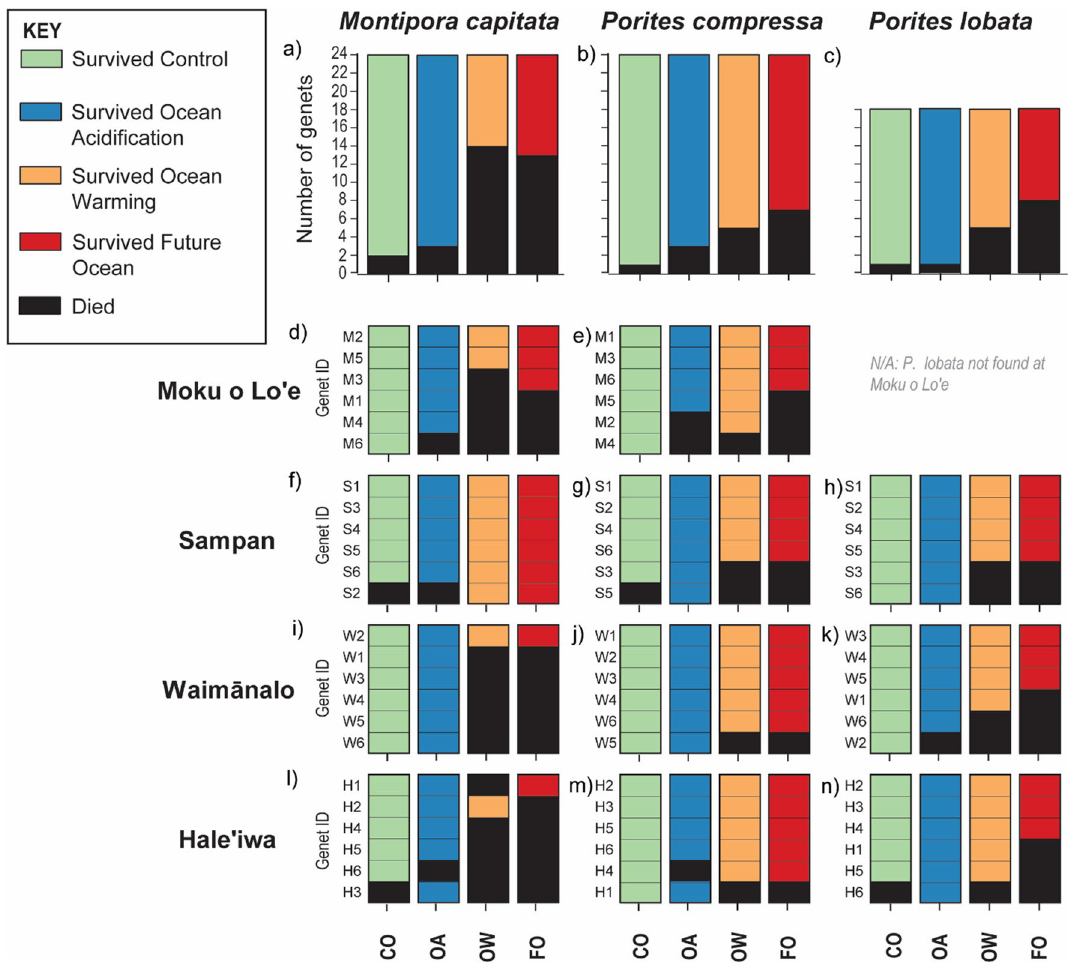
Figure 4. Survivorship of corals following 22 months exposure under control (CO, green), ocean acidification (OA, blue), ocean warming (OW, orange), or combined future ocean (FO, red) conditions for ( a ) M. capitata across sites, ( b ) P. compressa across site, ( c ) P. lobata across sites. Survivorship of the individual genets of each species collected from ( d – e ) Moku o Lo ʻ e, ( f – h ) Sampan, ( i – k ) Waimānalo, and ( l – n ) Hale ʻ